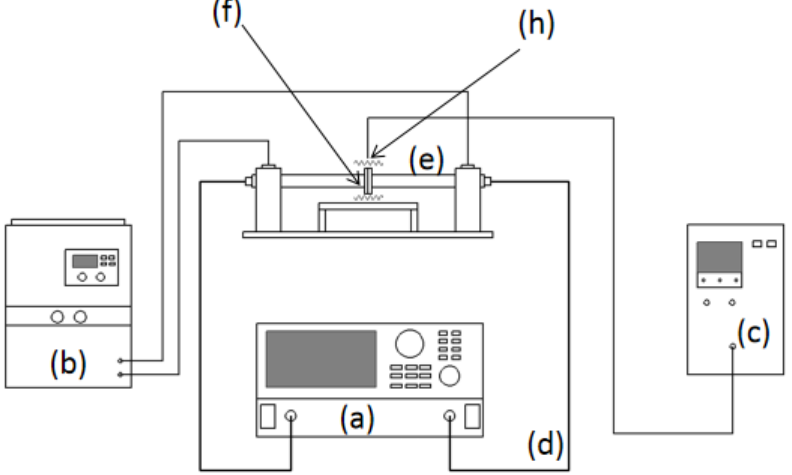
Figure 2. High-temperature electromagnetic parameter test system: ( a ) Vector network analyzer; ( b ) Cooling system; ( c ) thermostat; ( d ) Coaxial line; ( e ) Rectangular waveguide; ( f ) Sample; ( h ) Ther- mocouple.